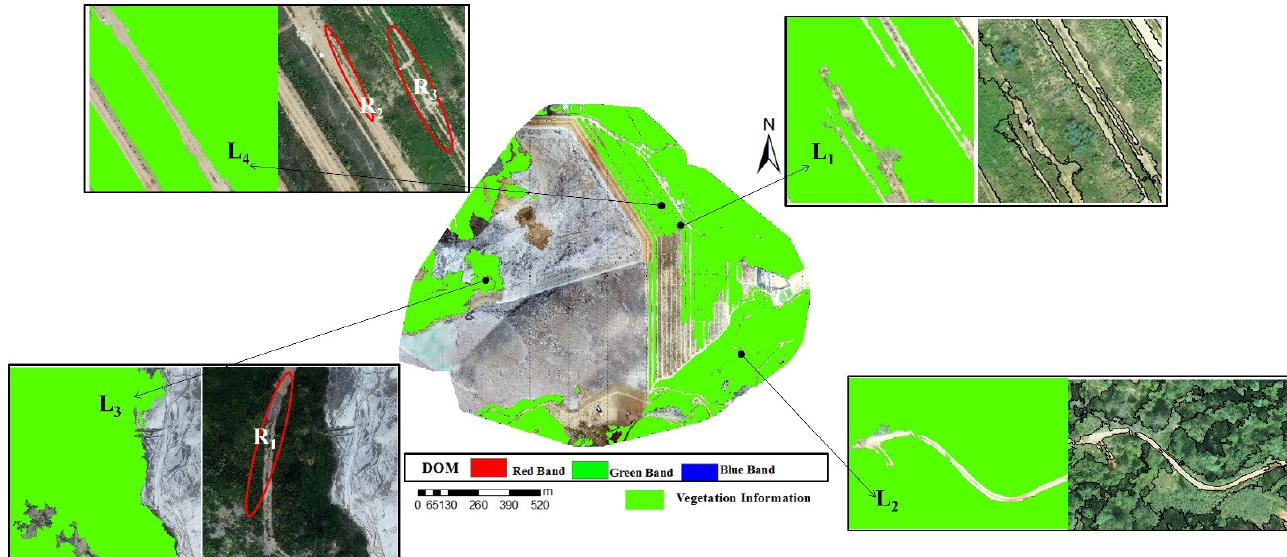
Figure 15. RF algorithm classification to extract vegetation information. L 1 and L 2 did not